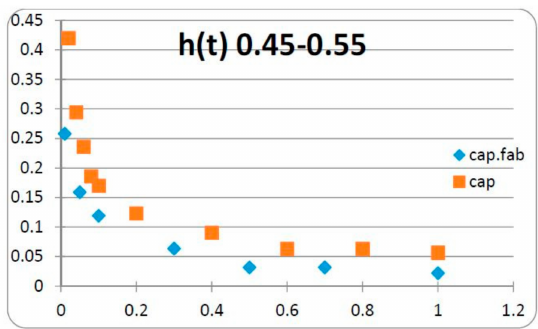
Figure 3. Comparison of the values of the kernels of Caputo DOFD and Caputo-Fabrizio DOFD when the order is distributed in the interval of integration (0.1–0.2).